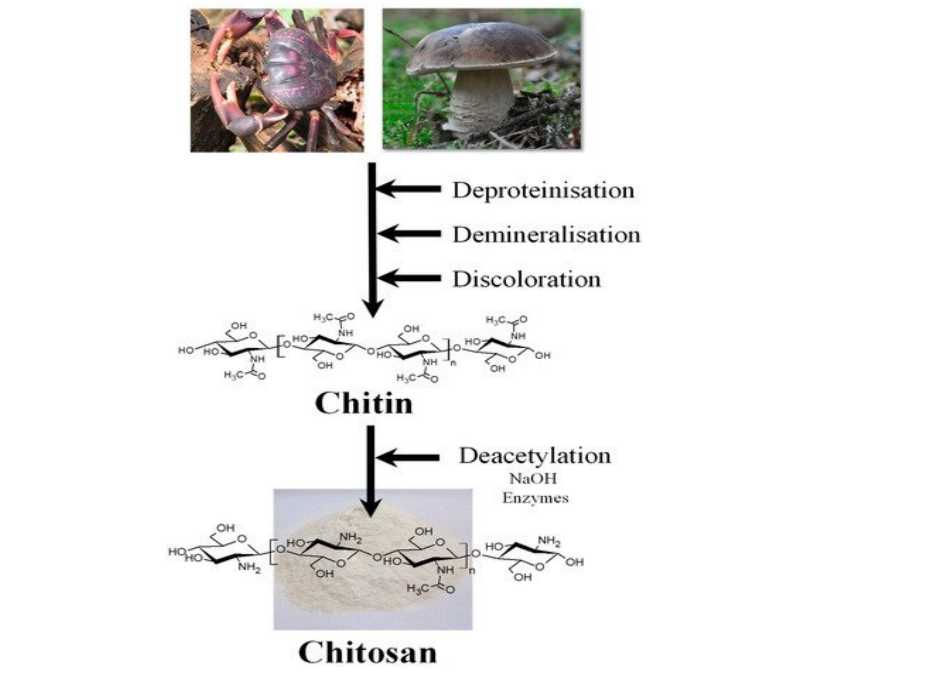
Figure 3. Mechanism of crustacean shell waste conversion into chitin and chitosan [53].